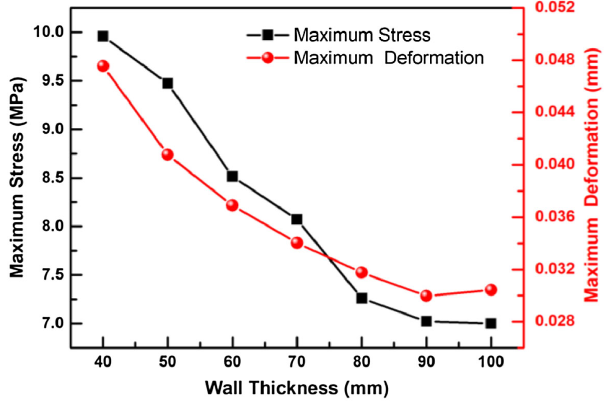
mm.FIG. 26. Influence of wall thickness on the maximum stress and deformation of RFQ